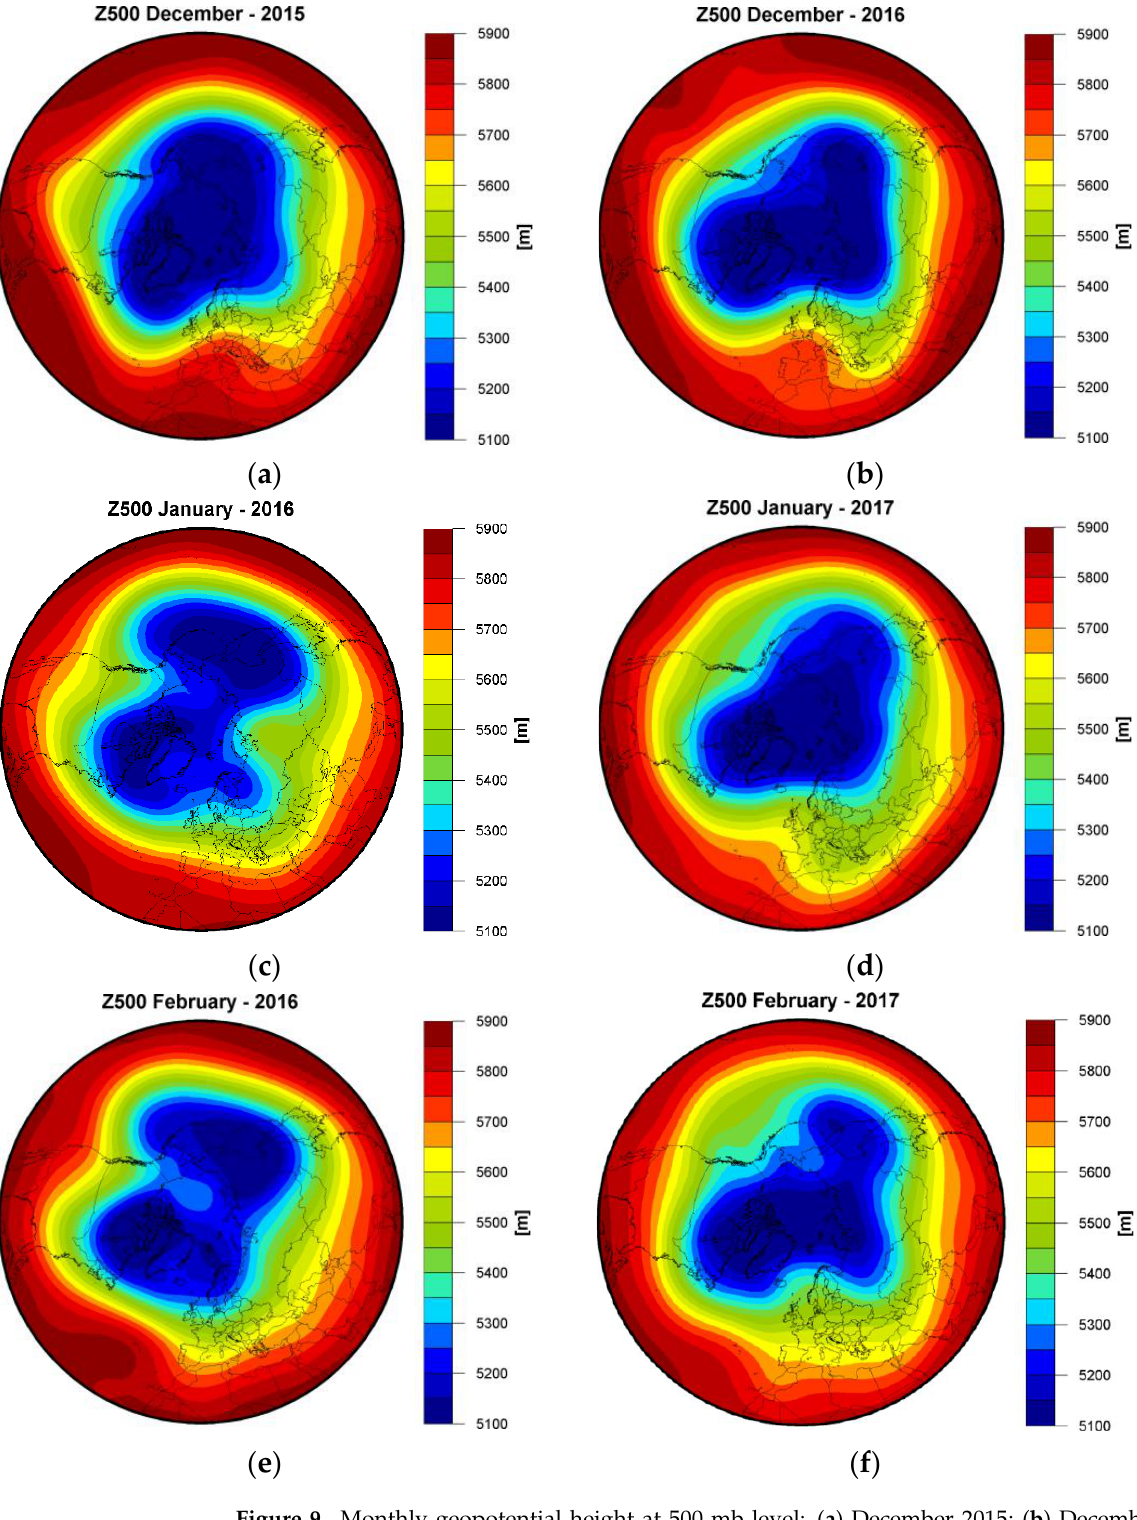
Figure 9. Monthly geopotential height at 500 mb level: ( a ) December 2015; ( b ) December 2016; ( c ) January 2016; ( d ) January 2017; ( e ) February 2016; and ( f ) February 2017.